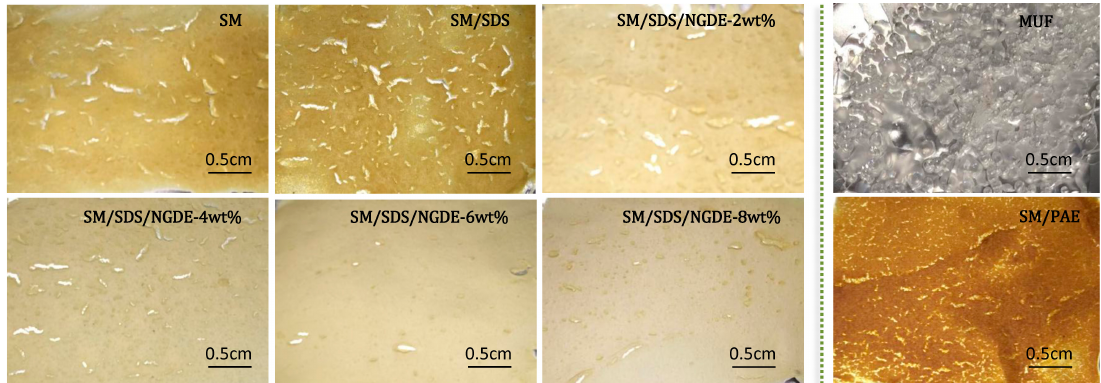
Figure 5. The crack observation of the different cured adhesives: 0 (SM adhesive), 1 (SM/SDS adhesive), 2 (SM/SDS/NGDE-2 adhesive), 3 (SM/SDS/NGDE-4 adhesive), 4 (SM/SDS/NGDE-6 adhesive), 5 (SM/SDS/NGDE-8 adhesive), 6 (SM/PAE adhesive), and 7 (MUF resin).